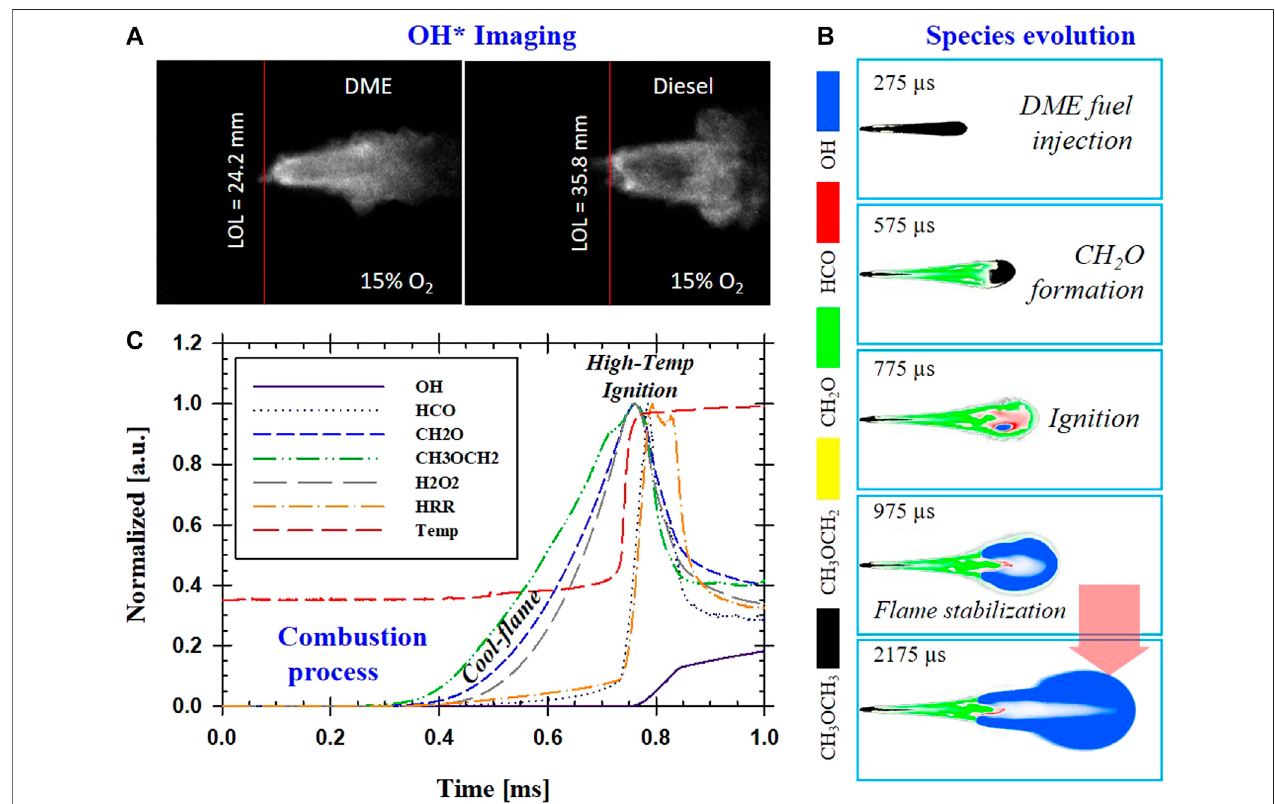
FIGURE 1 | (A) Example of OH* chemiluminescence images of DME and Diesel fl ame; (B) CFD time-elapsed evolution of selected species in DME reacting spray; (C) Temporal formation of key species in DME reacting spray.